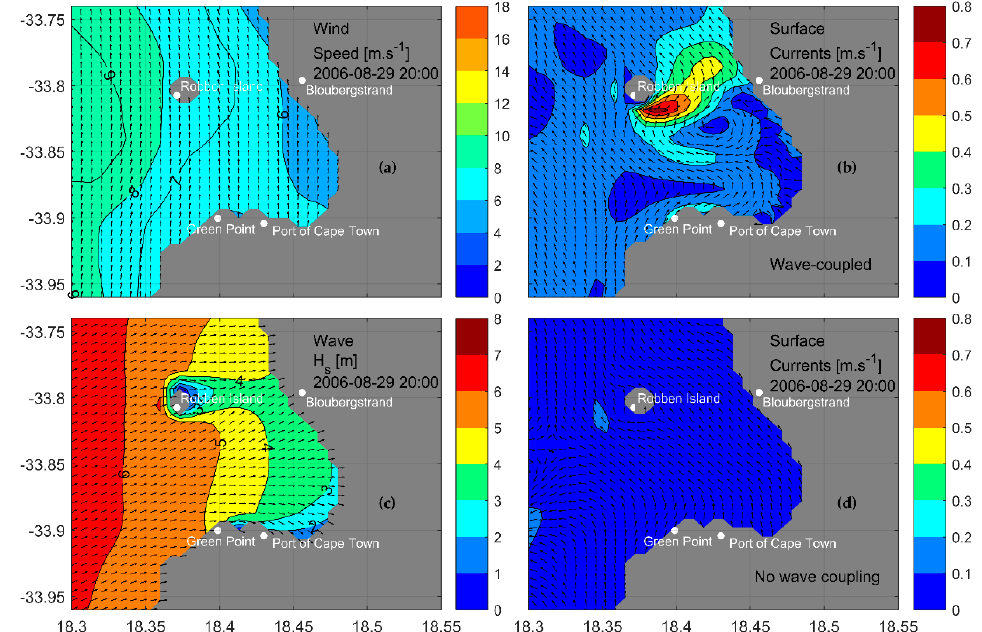
Figure 14. Eulerian surface currents in Table Bay from the wave-coupled HRM simulation ( b ) and HRM simulation without wave coupling ( d ), established during westerly winds ( a ) and large wave conditions ( c ).